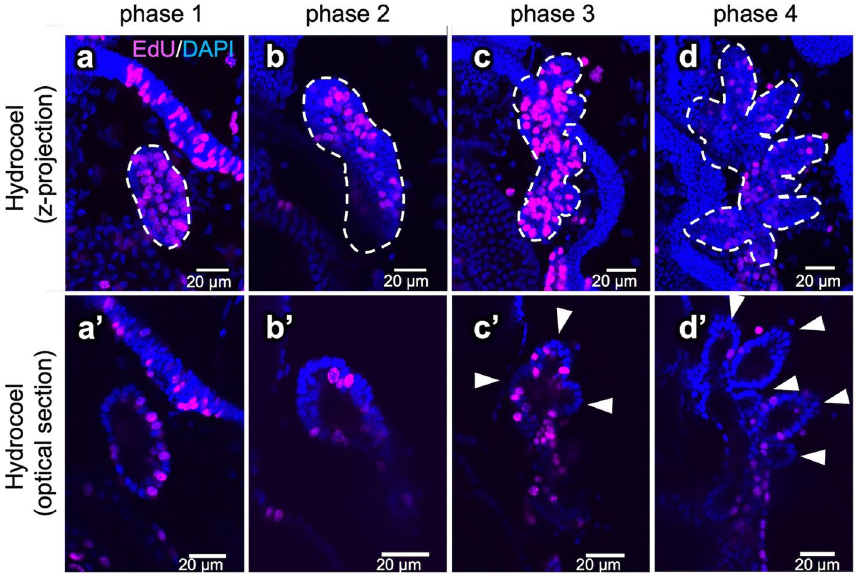
Figure 3. The spatial distribution of cell proliferation in the hydrocoel during the hydrocoel lobe morphogenesis. Cell proliferation in the hydrocoel from phase 1 to phase 4 was detected using EdU after 3 h of EdU treatment ( a–d ). The hydrocoel is indicated by the dotted lines. ( a’–d’ ) show the optical sections of ( a – c ). The position of the hydrocoel lobe is indicated by arrowheads. The EdU signal was detected equally throughout the whole hydrocoel during phase 1 and phase 4, and specific localization was not